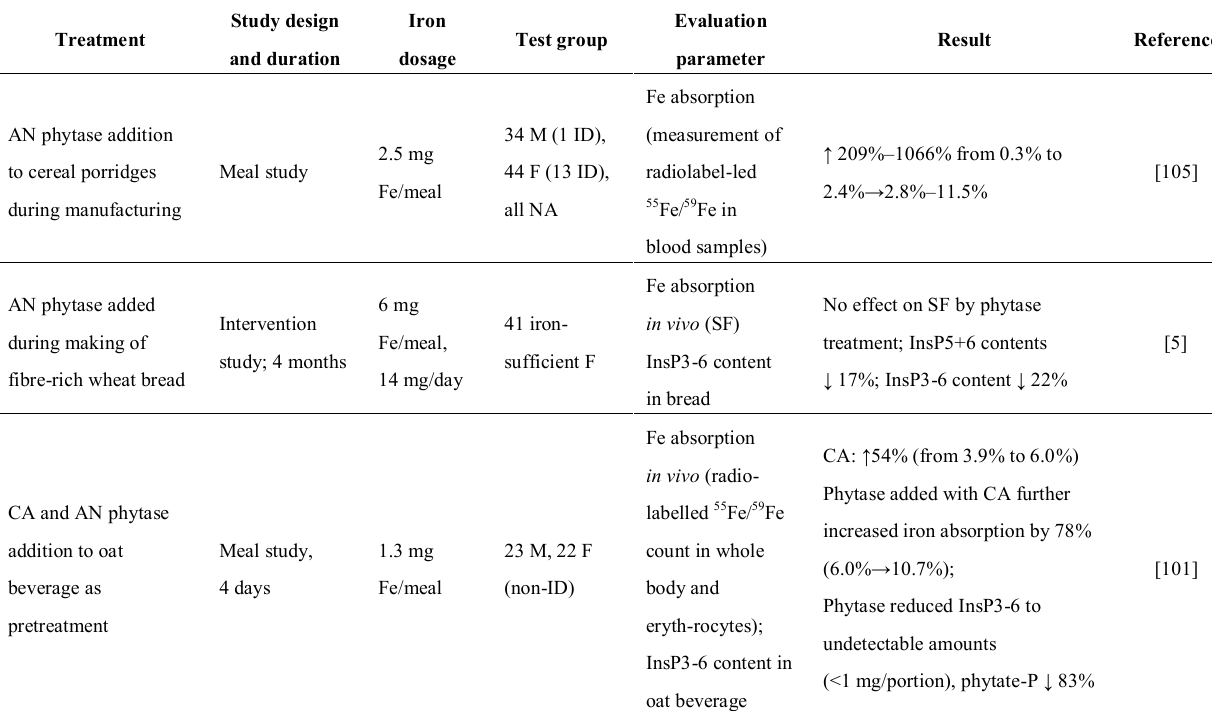
Table 3. Condensed results from studies employing ex vivo phytase catalysis evaluated on in vivo parameters. Abbreviations: CA: citric acid; AN: Aspergillus niger ; M: male; F: female; C: children; ID: iron deficient; NA: non-anaemic; SF: serum ferritin; InsP6: phytate; InsP3: myo -inositol triphosphate.